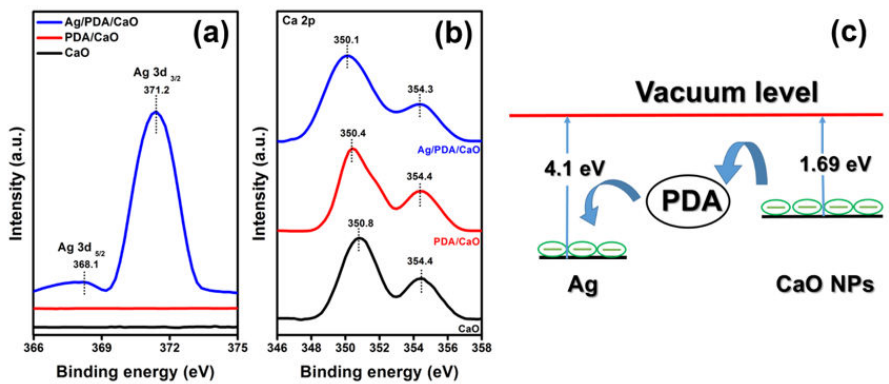
Figure 3. XPS spectra of ( a ) Ag 3d and ( b ) Ca 2p peak regions of the CaO NPs, PDA/CaO and Ag/PDA/CaO nanocomposites. ( c ) Scheme of charge transfer from CaO NPs to